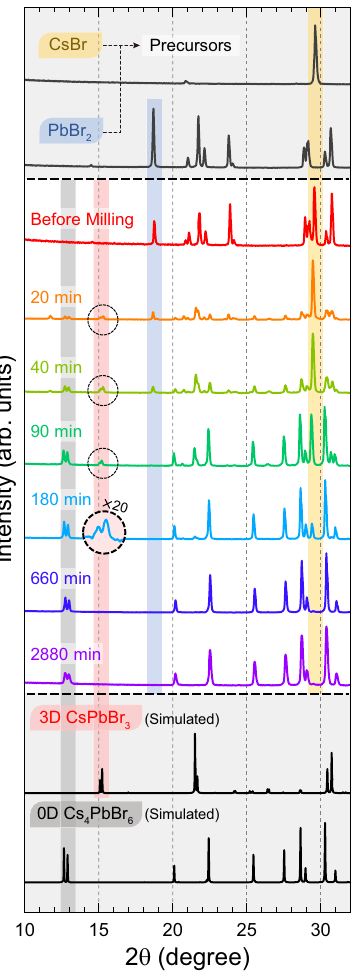
Fig. 3 Time evolution of perovskite structures through PXRD. PXRD patterns of CsBr and PbBr 2 (top gray panel), samples from different milling times (middle panel), and reference patterns for 3D CsPbBr 3 (COD ID 4510745; ref. 47 ) and 0D Cs 4 PbBr 6 (COD ID 4002857; ref. 22 ) (bottom gray panel). Representative peaks of CsBr, PbBr 2 , CsPbBr 3 , and Cs 4 PbBr 6 are marked by semi-transparent yellow, blue, red, and black strips, respectively. The full diffraction patterns are given in Supplementary Fig. 18. Source data are provided as a Source Data fi